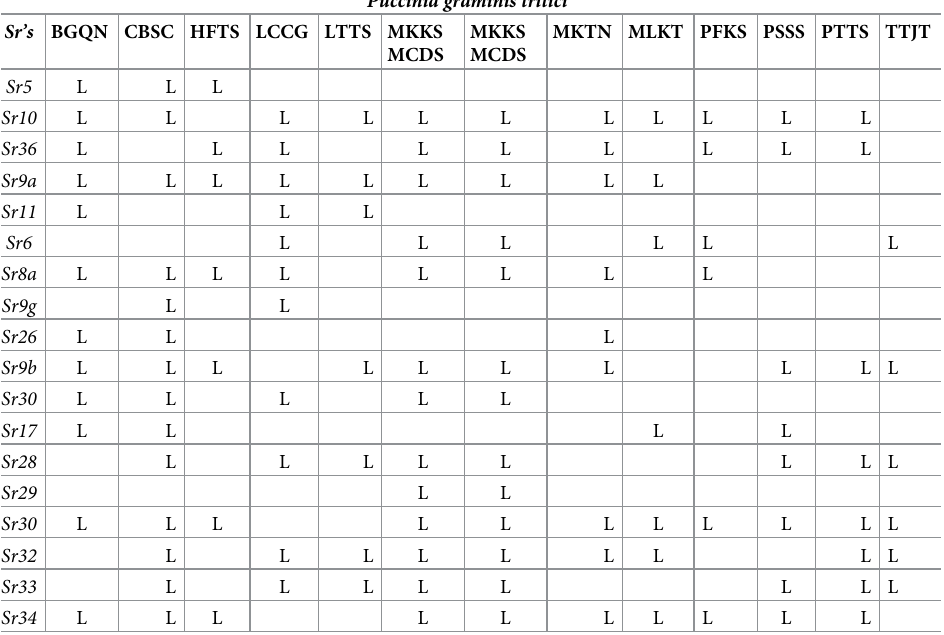
Table 5. Seedling reaction of 18 monogenic lines ( Sr’s ) tested against 13 races of Puccinia graminis f . sp . tritici under greenhouse conditions in 2019/2020. Puccinia graminis tritici